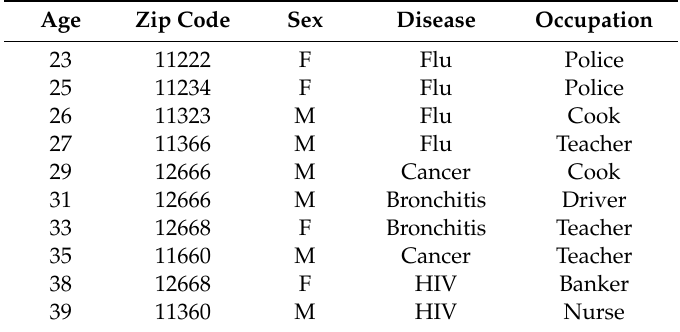
Table 7. Microdata with two quasi identifiers (QI) and two sensitive attributes